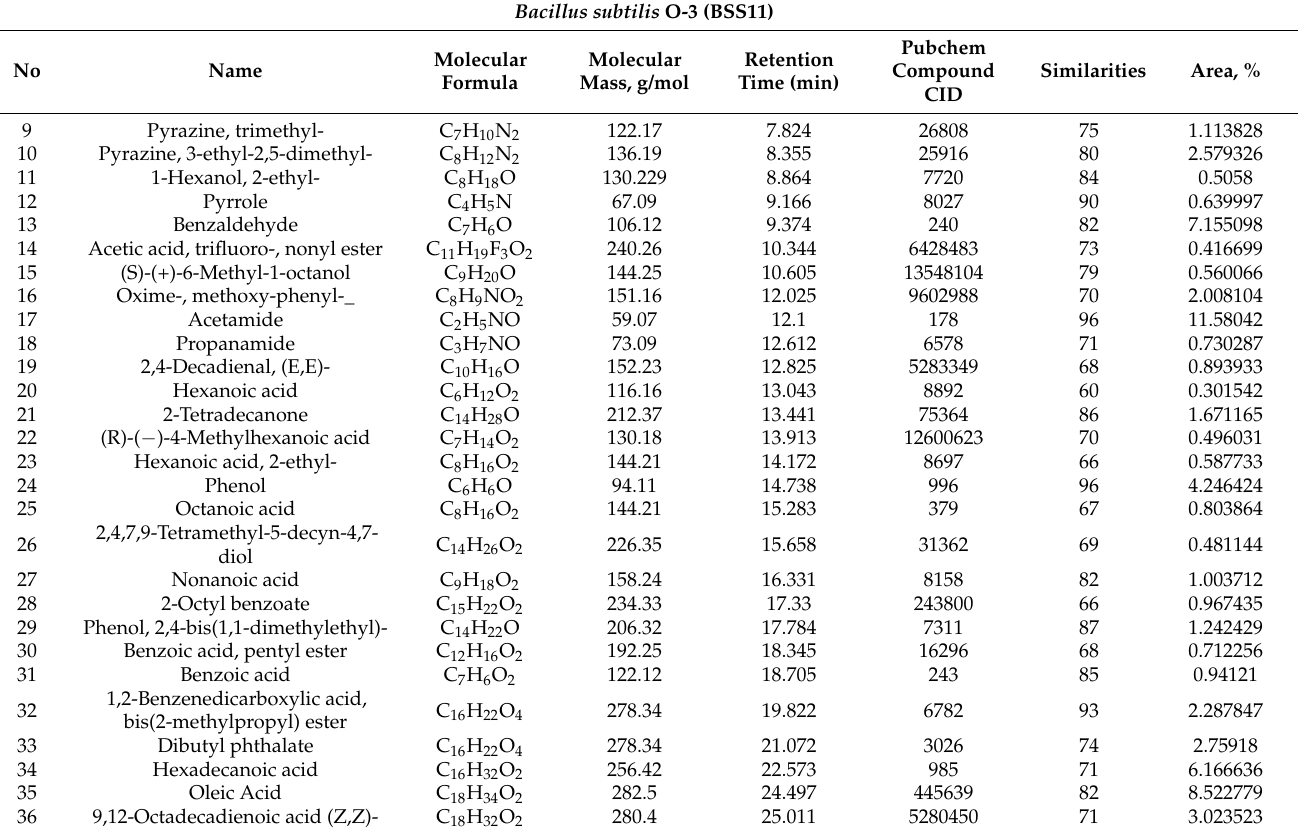
Bacillus subtilis O-3 (BSS11)